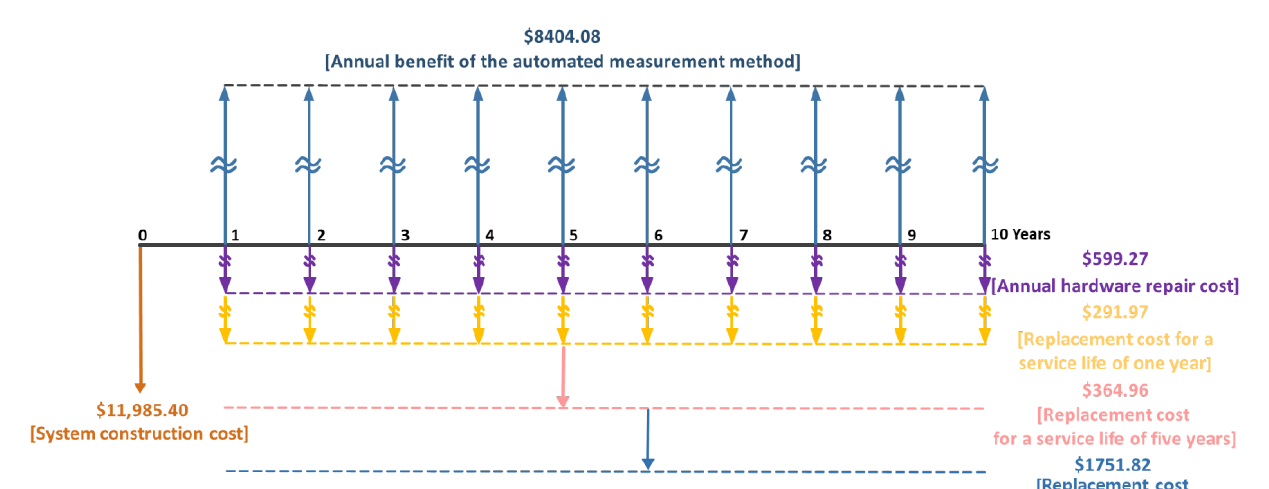
Figure 15. Cash flow diagram for the LCC analysis.